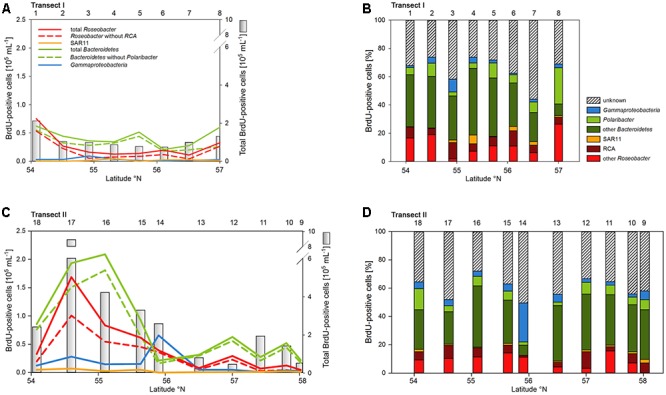
Cell numbers of the SAR11 clade, the Roseobacter group and its RCA cluster, Bacteroidetes and its Polaribacter cluster and of Gammaproteobacteria assessed by BrdU-FISH and numbers of total BrdU-positive cells of Transects I (upper panel) and II (lower panel) during early summer in the North Sea between 54° and 58°N. The red bars represent the Roseobacter group without the RCA cluster and the dark green bars Bacteroidetes without the Polaribacter cluster. The numbers above the panels indicate station numbers. (A,C) Show absolute cell numbers and (B,D) percentages of CARD-FISH cells detected by a group-specific BrdU-FISH probe.